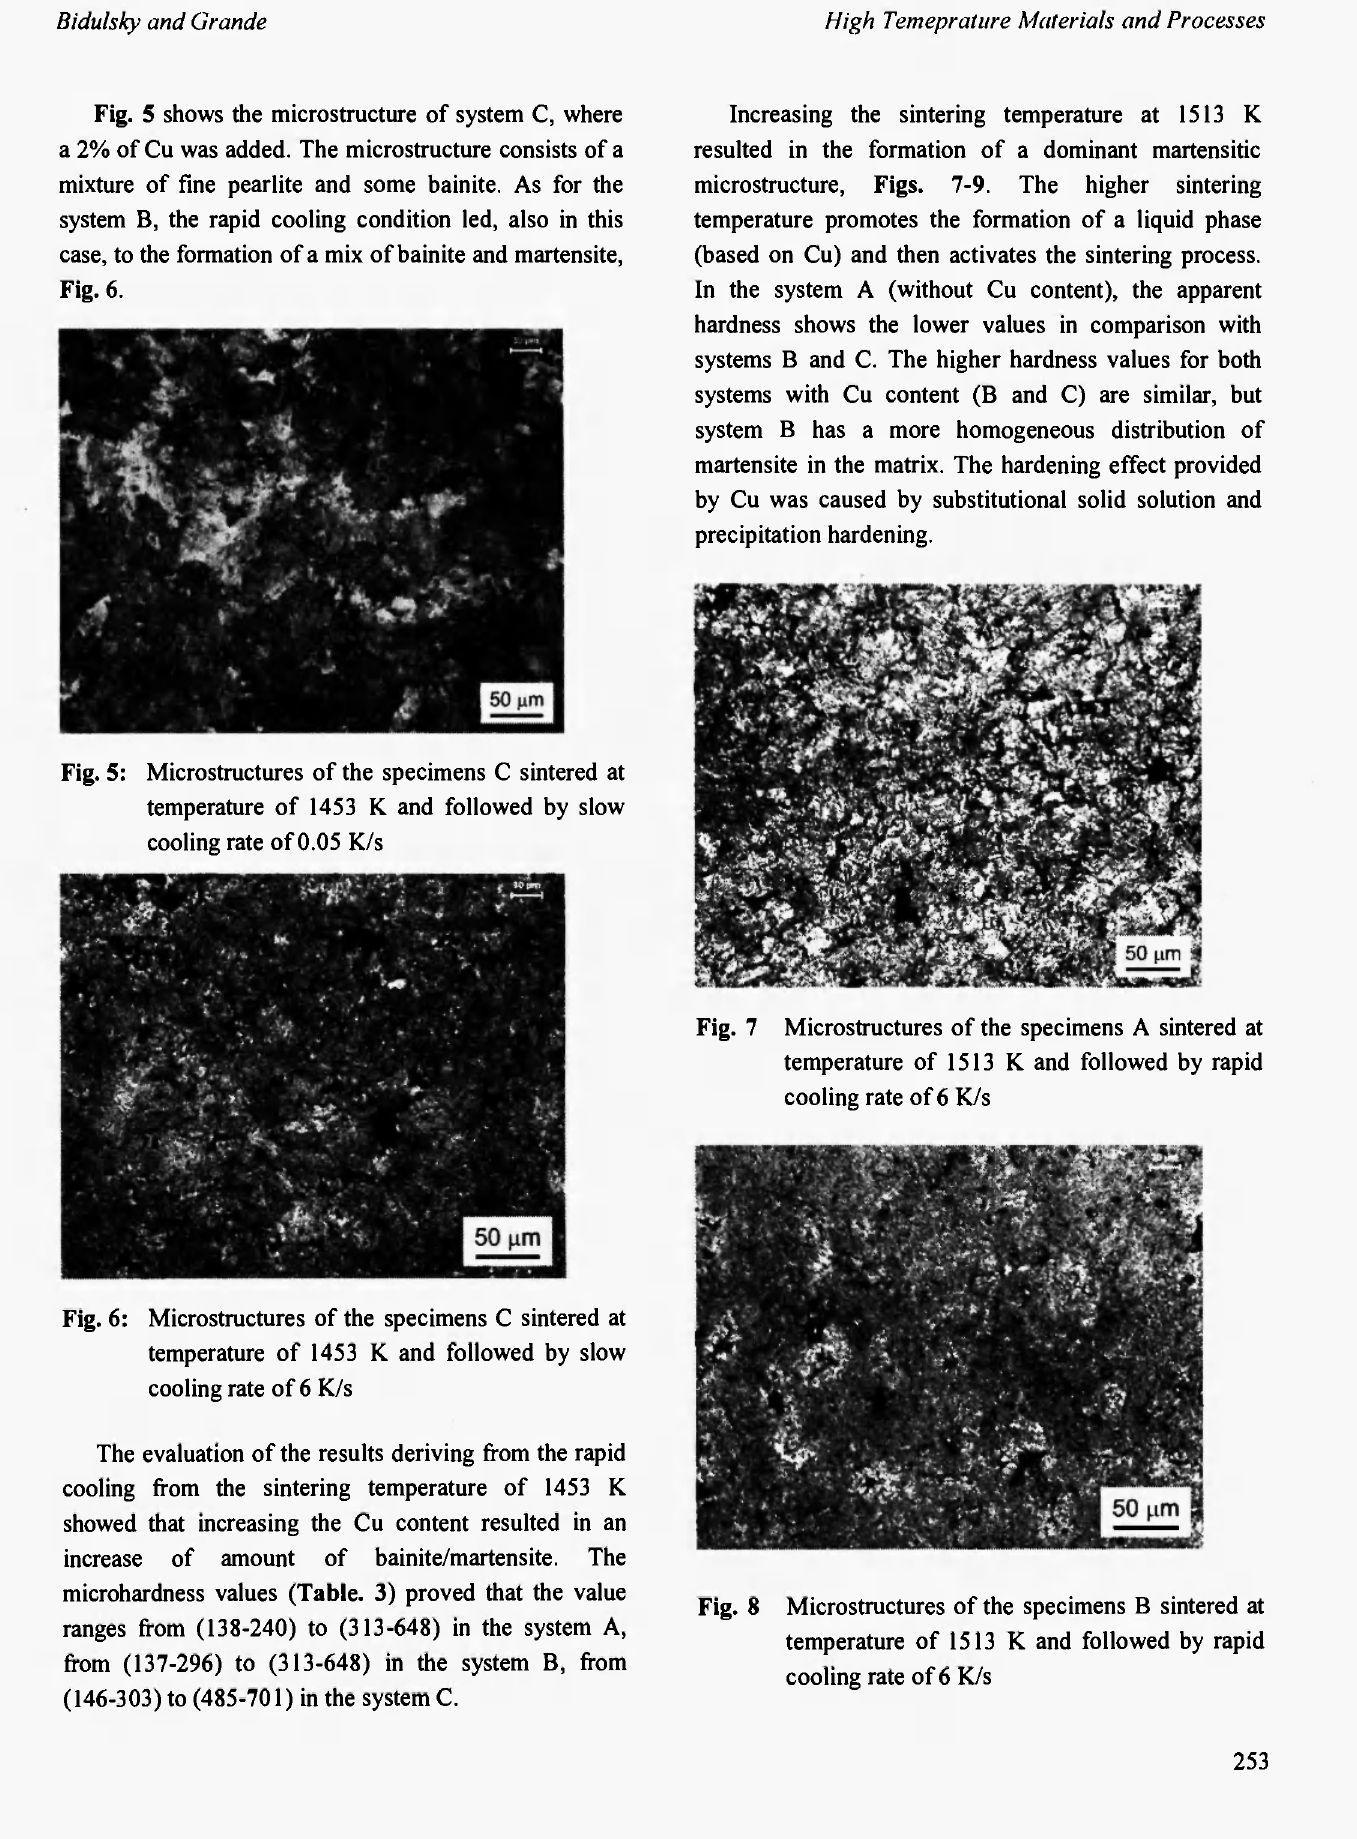
Microstructures of the specimens Β sintered at temperature of 1513 Κ and followed by